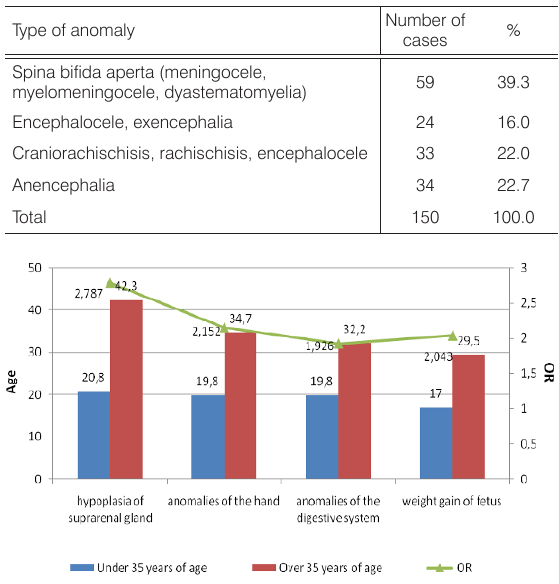
Table 1. Distribution of fetuses according to the type of NTD.